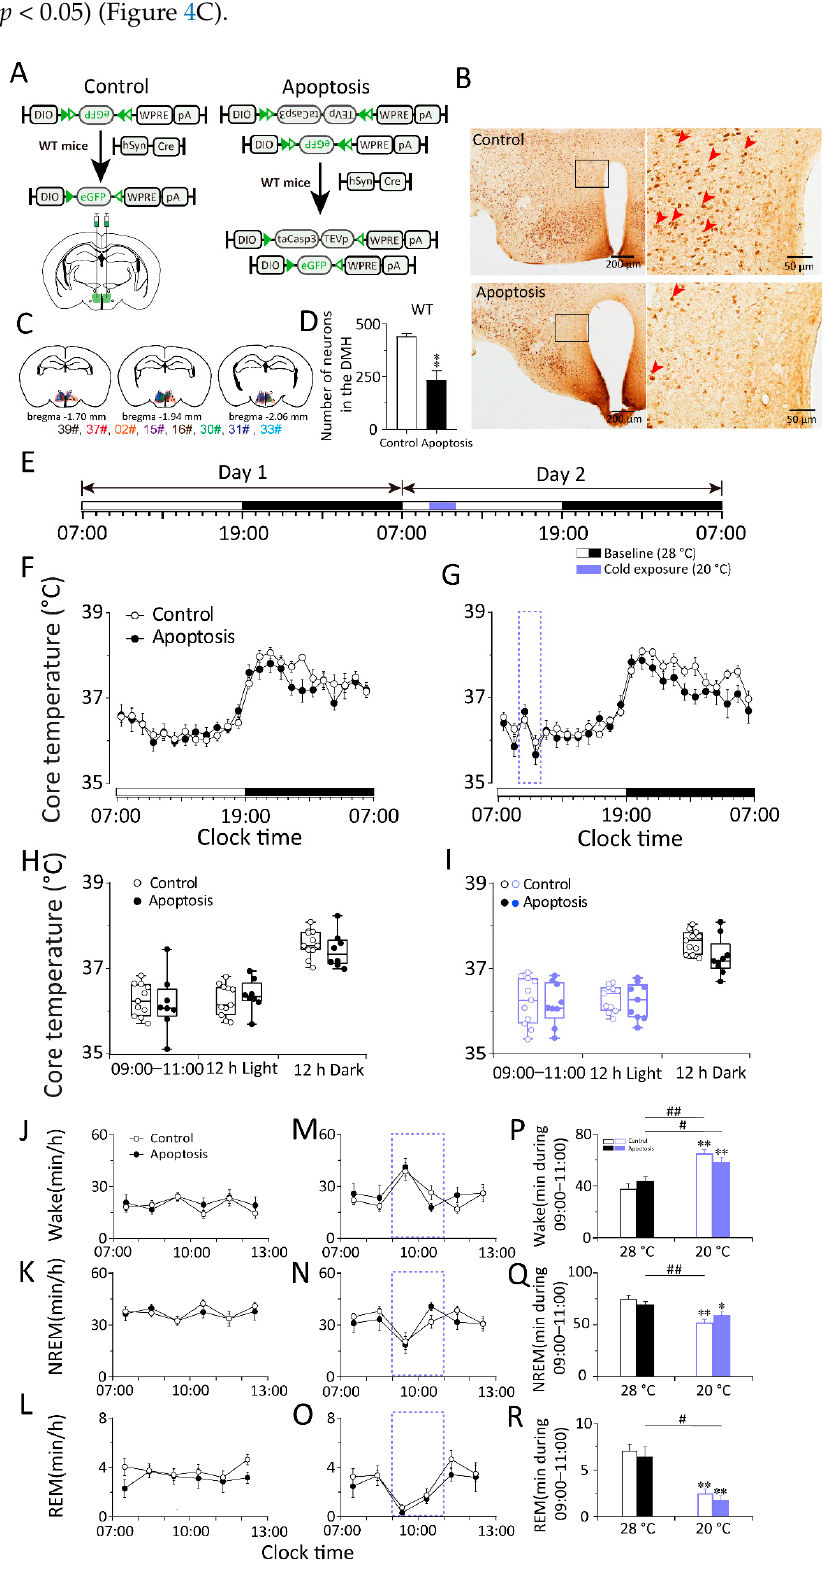
Figure 3. Cold exposure did not influence the core body temperature and sleep–wake cycle of co-trol or DMH apoptosis group in WT mice. ( A ) The schematic representation of nonspecific apoptosis